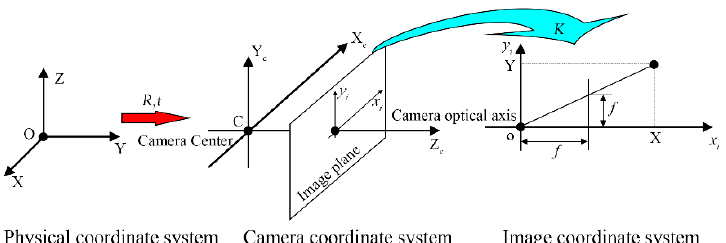
Figure 1. General steps for camera calibration.